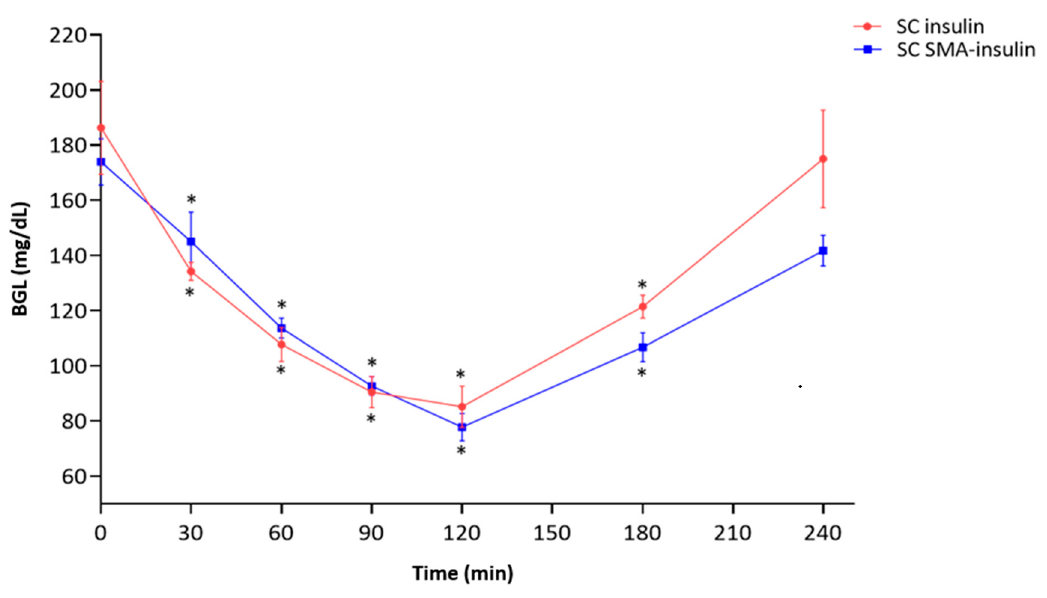
Figure 7. BGL profiles following subcutaneous administration of insulin and SMA-insulin. Animals fasted overnight before insulin or SMA-insulin (2 mg / kg) subcutaneous injection. BGL was measured for 4 h at regular intervals using a glucometer. Data are stated as mean ± SD ( n = 6 / group). The mean of BGL was analyzed using a one-way ANOVA * p < 0.05 denotes statistical significance.